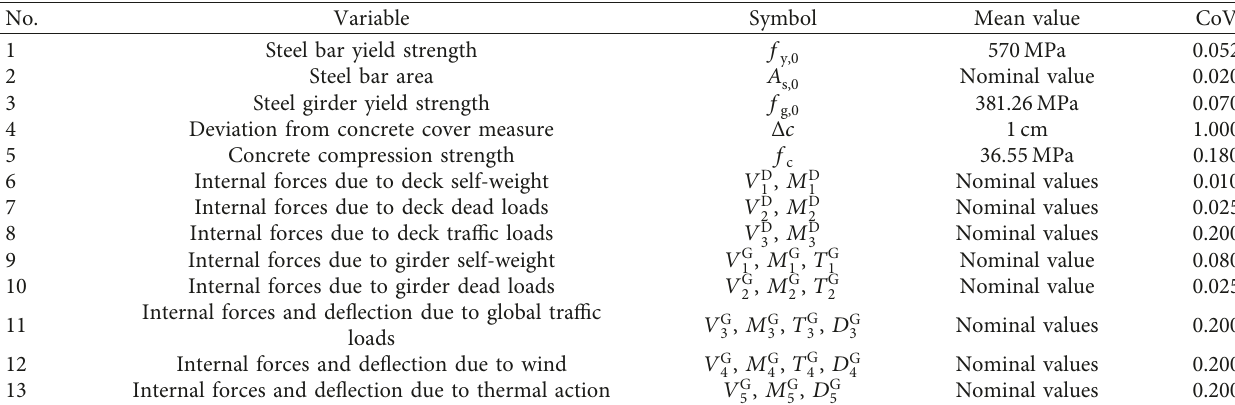
Figure 8: Degradation model as a function of time ( t ) (a) and representation of the decrease of A Table 1: Random variables used in the case study.